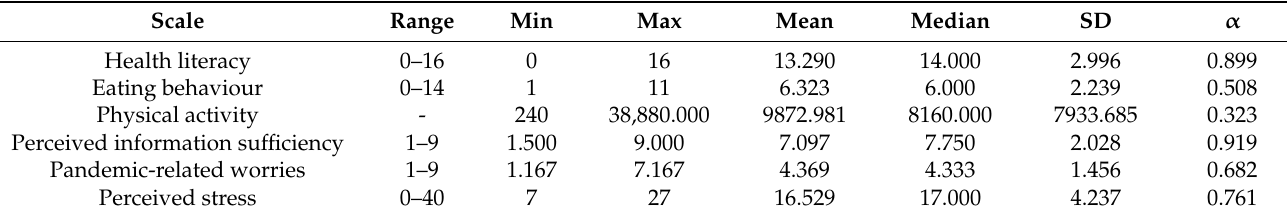
Table 2. Variable characteristics and internal consistencies of